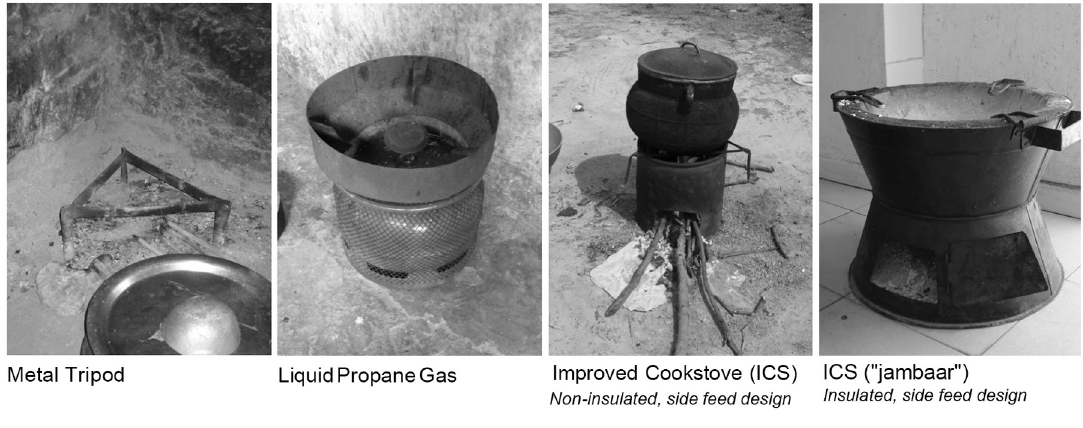
Fig 2. Images of cookstoves used in survey